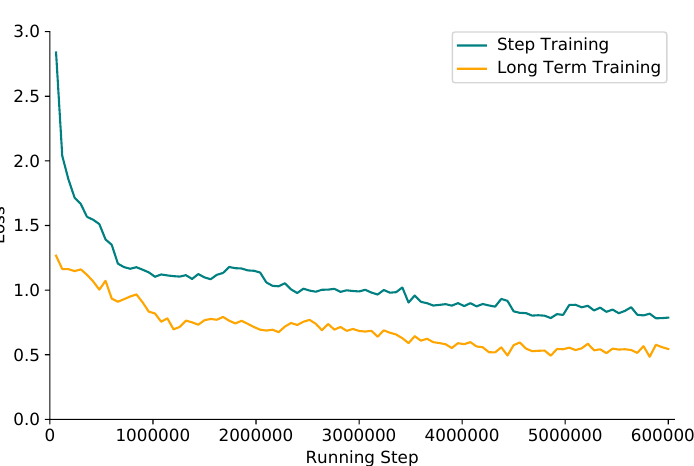
Figure 13. Different convergence processes of deep Q network loss value during the whole training.